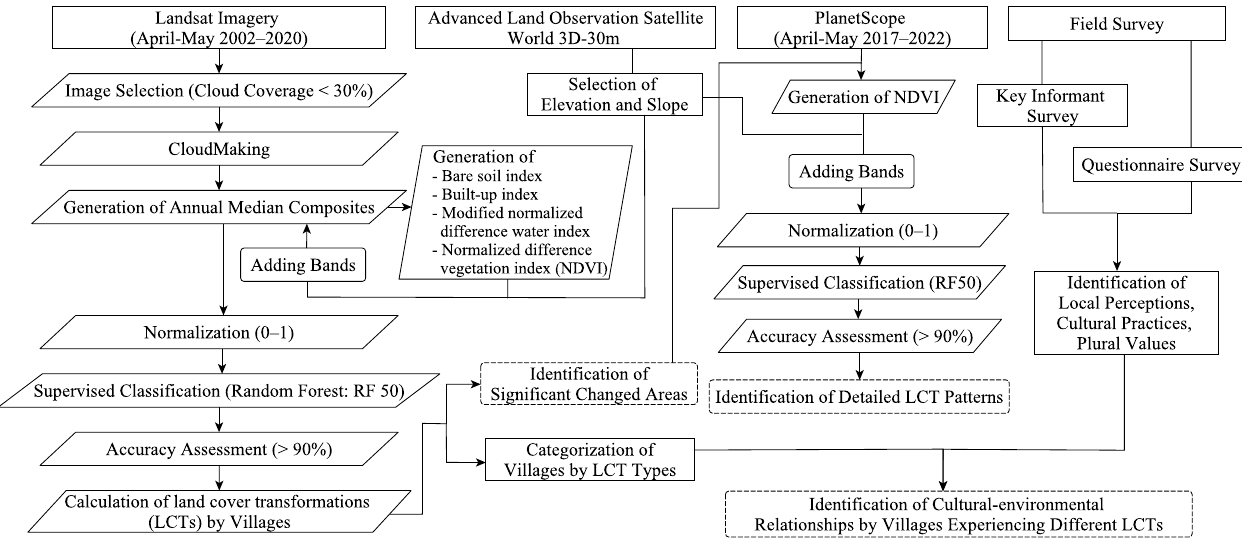
Figure 1. Overall methodological